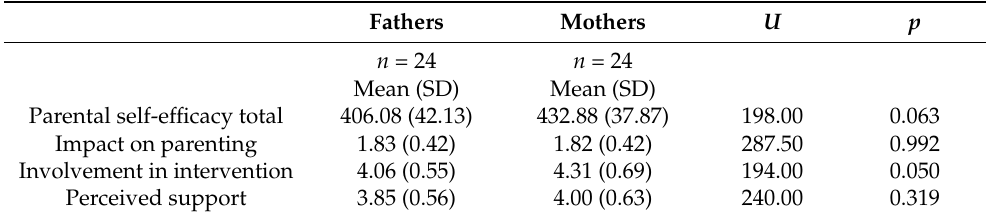
Table 3. Means and standard deviations of fathers’ and mothers’ study variables (parental self-efficacy, impact on parenting, involvement in intervention, and perceived